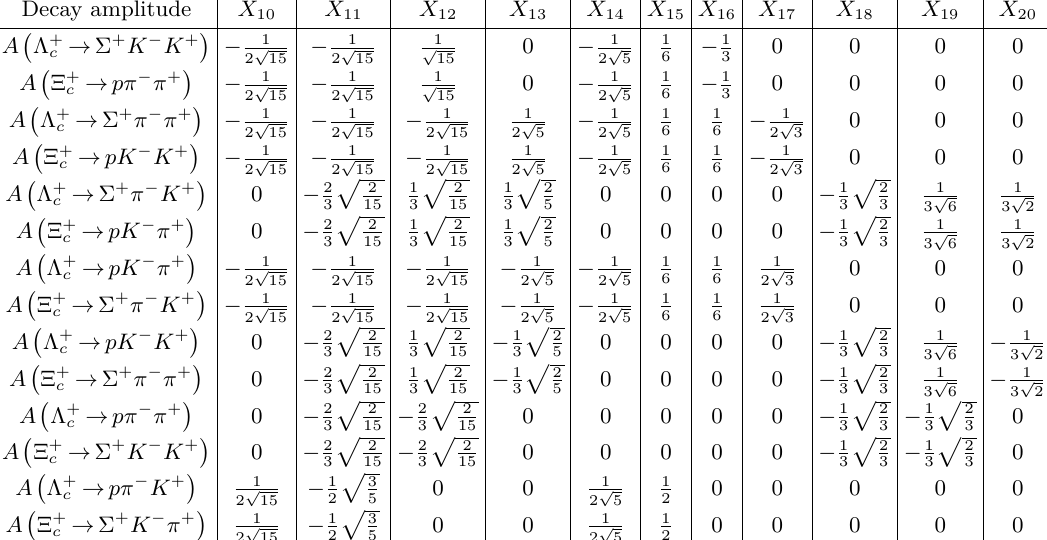
Table 10 . Contributions to the RME decomposition C b → L b P − P + from second order U -spin breaking ( b = 2 ). The corresponding RMEs X